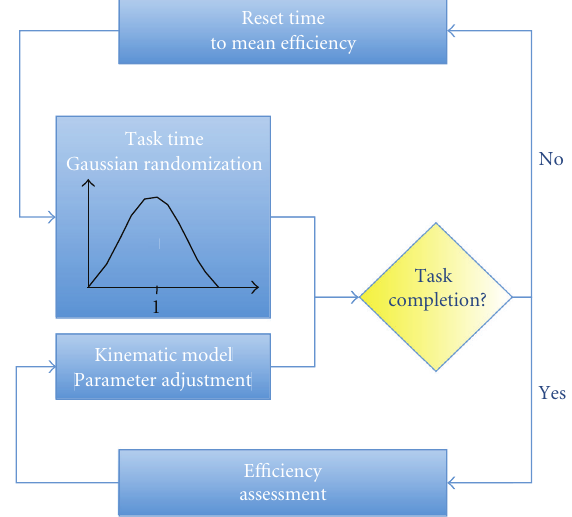
Figure 5: NTT personalization process. The adaptation of the training parameters is realized according to the patient’s e ffi ciency in the task. A kinematic model maps training objectives to individual NTT parameters. In parallel, a timer is used to create a time-race task. See text for further